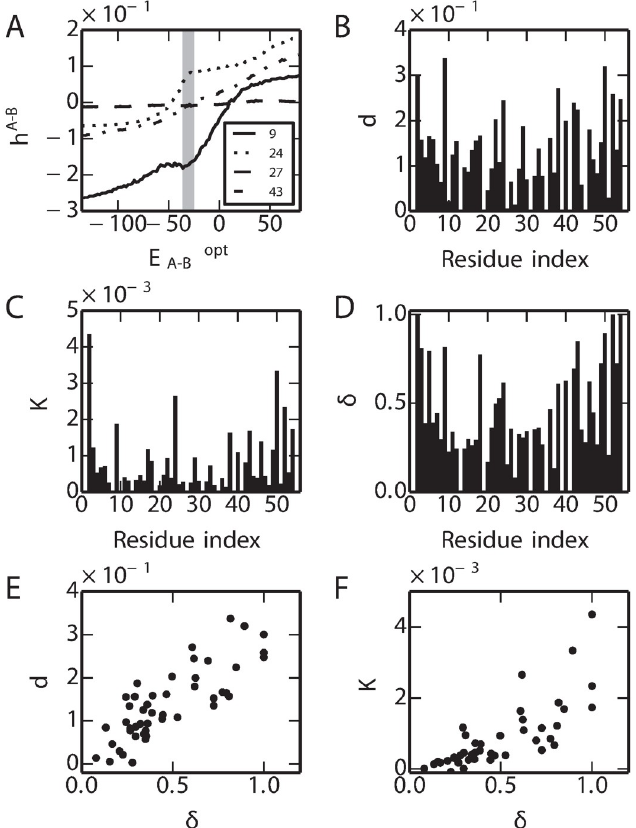
Fig 6. Single-site amino acid propensity changes in fold switching. (A) Examples of h A-B for residues 9, 24, 27, 43. (B) Total change ( d ) of h A-B from GA to GB. (C) Slope (K) at the transition region where it corresponds to ϕ [0.2,0.8]. The δ (D) and its correlation with d and K are show in (E) and